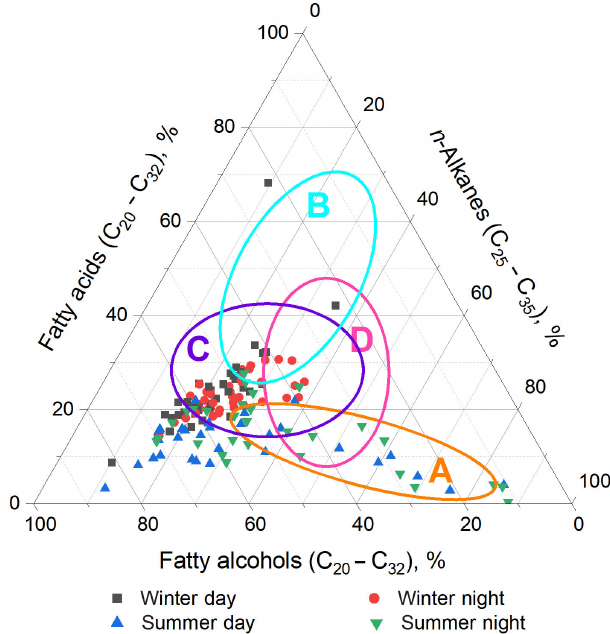
Figure 6. Triangular plots of the relative abundances of biomarkers detected in Tianjin aerosols during the wintertime and summertime. Three main terrestrial plant waxes, including n -alkanes (C 25 -C 35 ), fatty acids (C 20 -C 32 ), and fatty alcohols (C 20 -C 32 ), are represented by four different shaped points. Categories A and B are marine aerosols that were collected over the East China Sea (Kang et al., 2017) in summer and on Chichi-Jima Island in the western North Pacific from April 1990 to November 1993 respectively (Kawamura et al., 2003a). Category C represents mountain aerosols from Mt. Tai, China, in summer (Fu et al., 2008), and category D represents urban aerosols from Beijing in winter (Ren et al.,